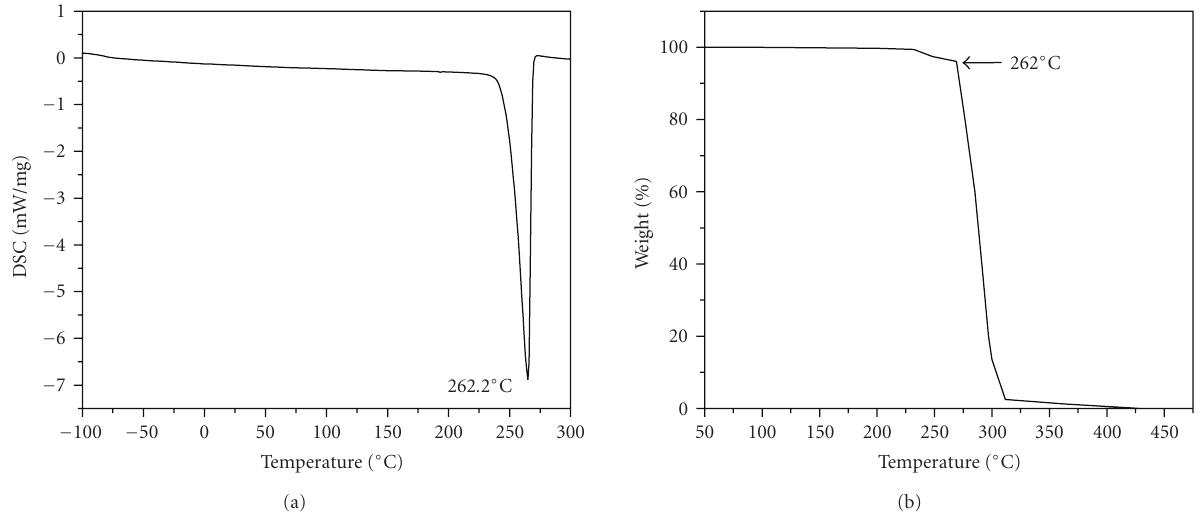
Figure 18: (a) DSC curve of L-threonine. (b) TGA curve of